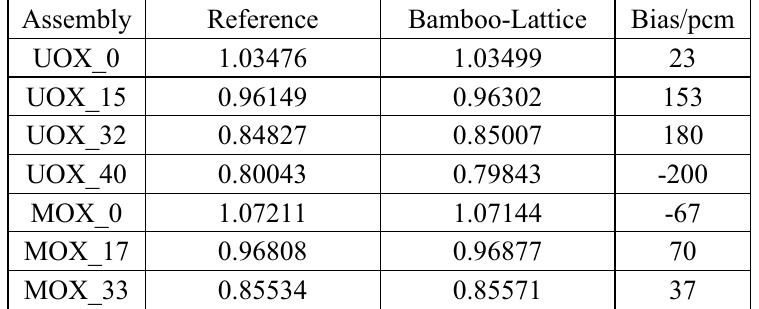
Figure 4. Assembly arrangement in the VVER-1000 core. Table (cid:266) . Effective multiplication factors of the 7 assemblies.